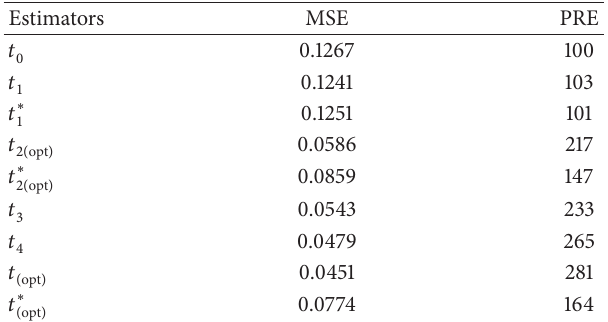
Table 1: The MSE and PRE of the different estimators with respect to 𝑡 0